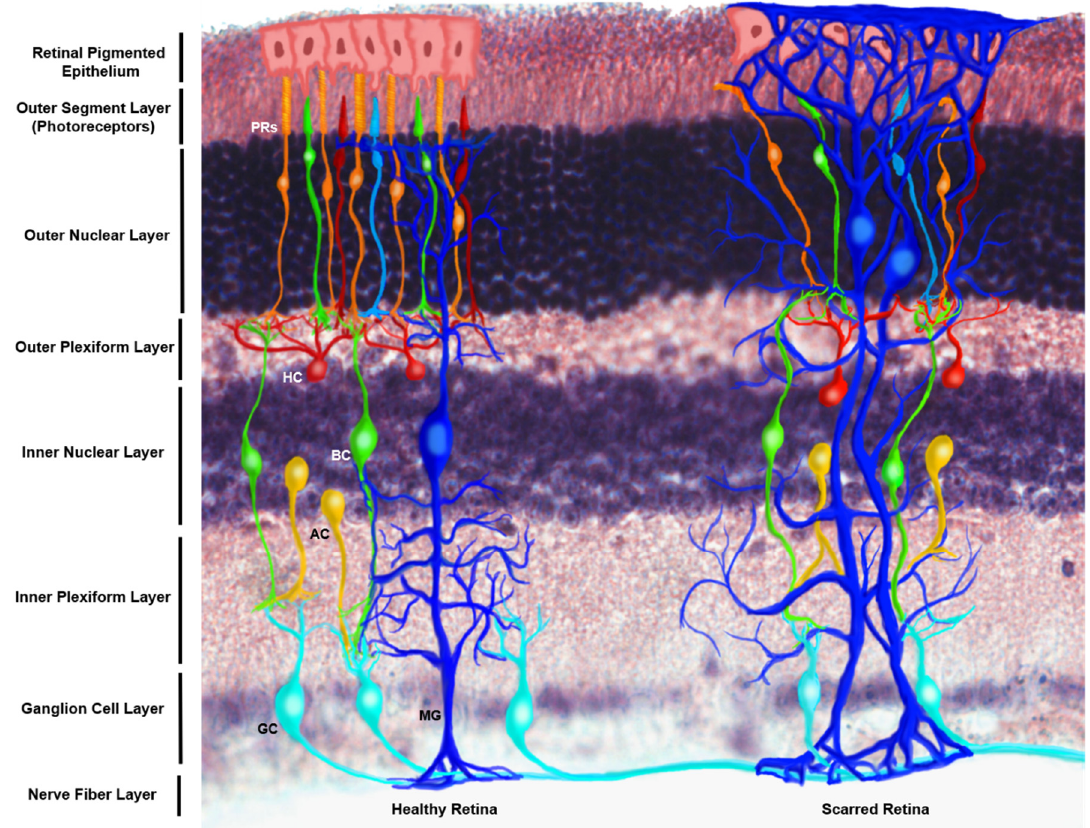
Figure 1. Schematic of the structural distribution of Müller glia (MG) within the healthy and scarred mammalian retina. This figure makes use of an immunostained retinal cross section of the N1CR2 murine model, created to drive up green fluorescent protein (GFP) in interneuron progenitors without changes in retinal structure, function or intrinsic cellular expression based on the transgene [10]. From the posterior to anterior side of the retina (bottom to top) end ‐ feet of MG can be appreciated at the nerve fiber layer, extending their processes through the inner plexiform layer to the inner nuclear layer, where their nuclei reside. MG processes extend up to the interception of the outer nuclear layer and the outer segment layer, constituting the outer limiting membrane, which serves as a biochemical and physical barrier for the retinal tissue. (Left) Healthy retina featuring the nerve fiber layer, which is made of ganglion cells (GC) axons, whose bodies reside in the ganglion cell layer, followed by the inner plexiform layer where ganglion cells connect with amacrine cells (AC) and bipolar cells (BC), whose cell bodies are found in the inner nuclear layer; followed by their connection to horizontal cells (HC) and photoreceptors (PRs) at the outer plexiform layer. Bodies of photoreceptors align in the outer nuclear layer, while the photoreceptor disks lie on the outer segment layer, adjacent to the retinal pigmented epithelium (RPE), which selectively permeates molecules from the choriocapillary network. (Right) Scarring of the anterior side of the retina is characterized by the extension of MG processes beyond the outer limiting membrane into the RPE, which combined with extracellular matrix deposition and addition of glycoproteins comprise the scar that displaces the endogenous cells of the tissue and impedes regeneration.